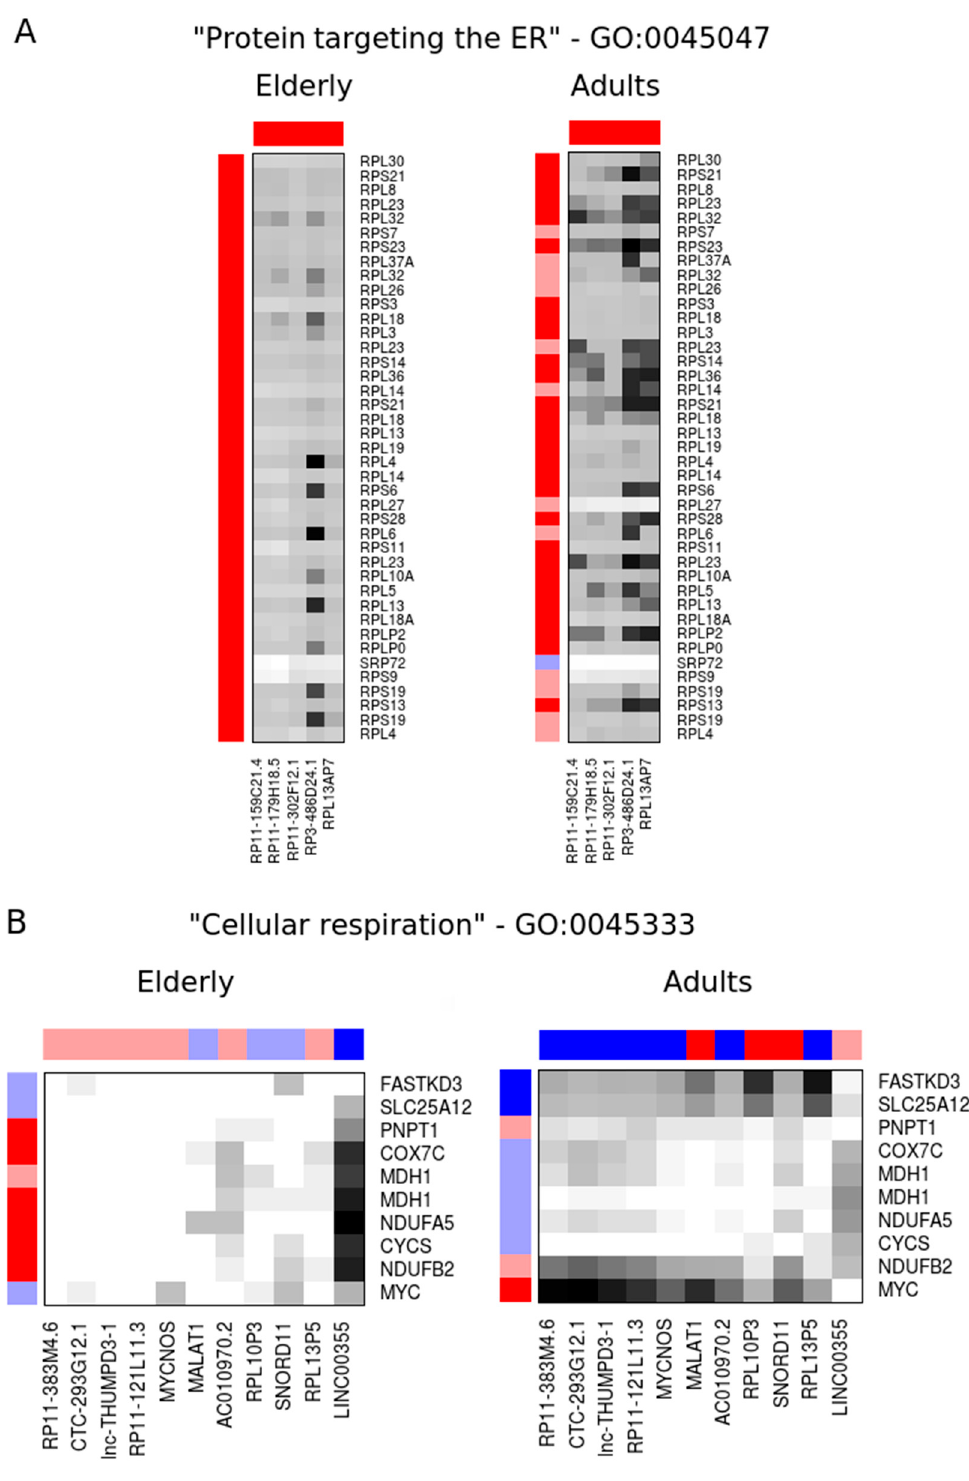
Figure 3. Elderly and adult co-expression networks of selected lncRNAs (columns) and protein-coding mRNAs (rows) in molecular pathways enriched among the most connected ( A ) or the most differentially connected ( B ) genes. Heatmap colors show the network similarity between each gene pair, with black being the most similar and white the least similar. The gene expression ratios are shown as external bars, where dark blue and red indicate transcripts significantly upregulated or downregulated in sepsis relative to controls ( p ≤ 0.01), respectively.